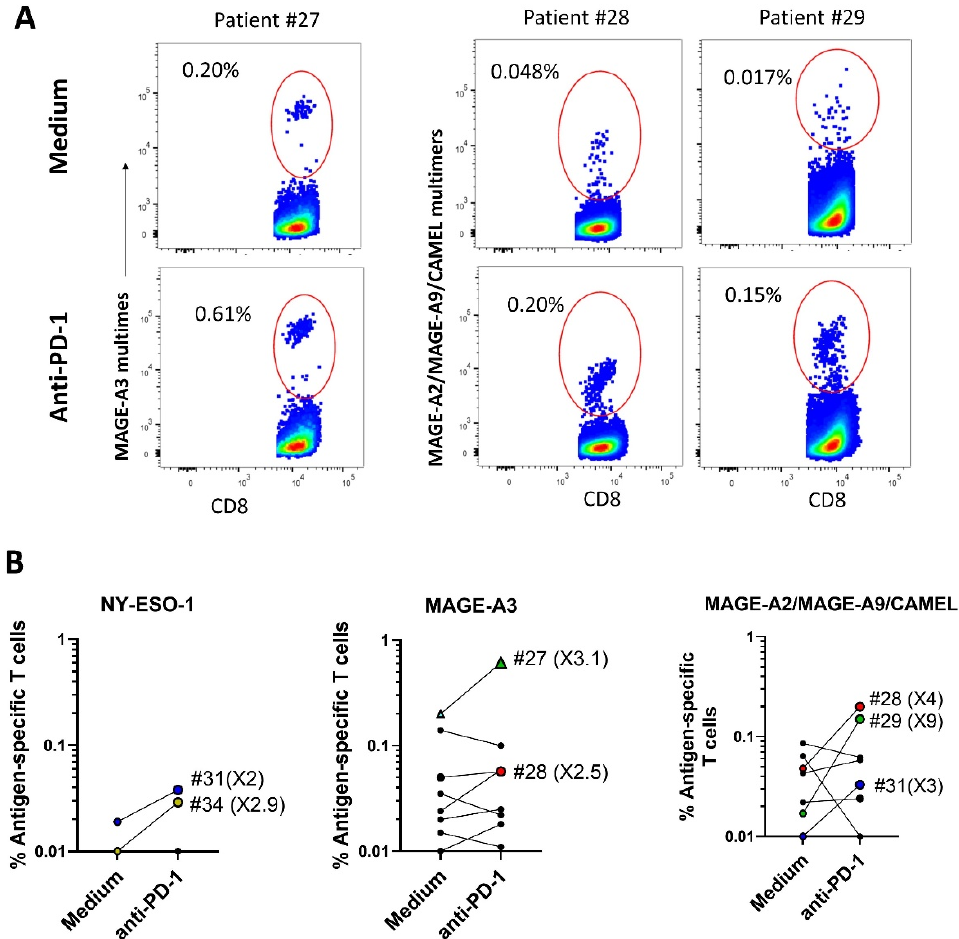
Figure 4. Effect of anti-PD-1 antibodies on the PDC*line-cell-induced T-cell response in NSCLC patients. Patients’ PBMCs and tumor-peptide-loaded PDC*line cells were cultured in the presence or absence of anti-PD-1 antibodies. The proportion of antigen-specific CD8+ T cells (ASTC) was measured by fluorescent multimer labeling at the end of the coculture. To detect MAGE-A2-, MAGE-A9- and CAMEL-specific ASTCs, a mix of specific dextramers conjugated to the same fluorochrome was used. ( A ) Illustrative pseudocolor dot plots showing the effect of anti-PD-1 antibodies on the proportion of ASTCs for three different patients. ( B ) Effect of anti-PD-1 antibodies on the expansion of specific ASTCs in the whole population of patients. Colored symbols indicate a positive effect of anti-PD-1 antibodies, and each color represents a different patient (e.g., patient #31 is represented with a blue circle). Increases greater than twofold are indicated in brackets.